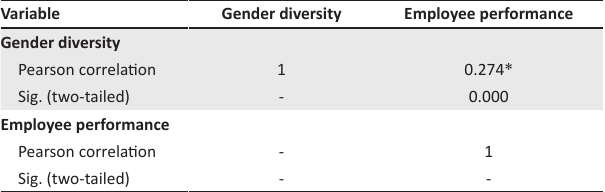
TABLE 6: Correlation between gender diversity and employee performance.